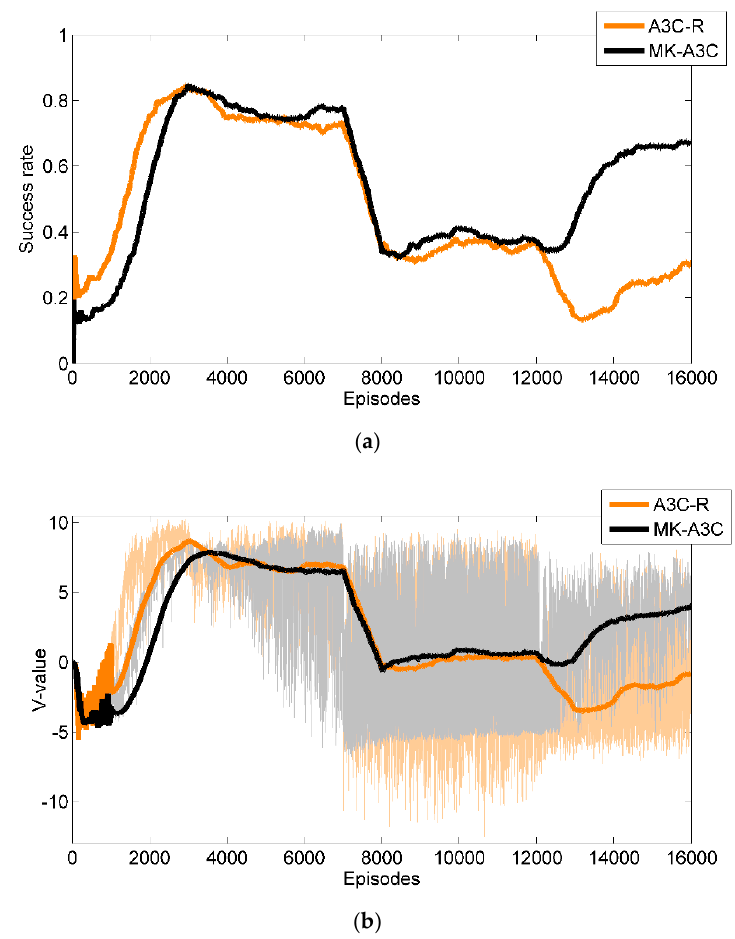
Figure 6. The performance of our method MK-A3C and A3C-R in the training phase. ( a ) The orange and black lines denote success rates of A3C-R and MK-A3C, respectively; ( b ) The light orange and gray lines represent data of V -value, and the overstriking orange and black lines denote the mean V -value of the last 1000 episodes. ( a ) Success rate; ( b ) V -value.